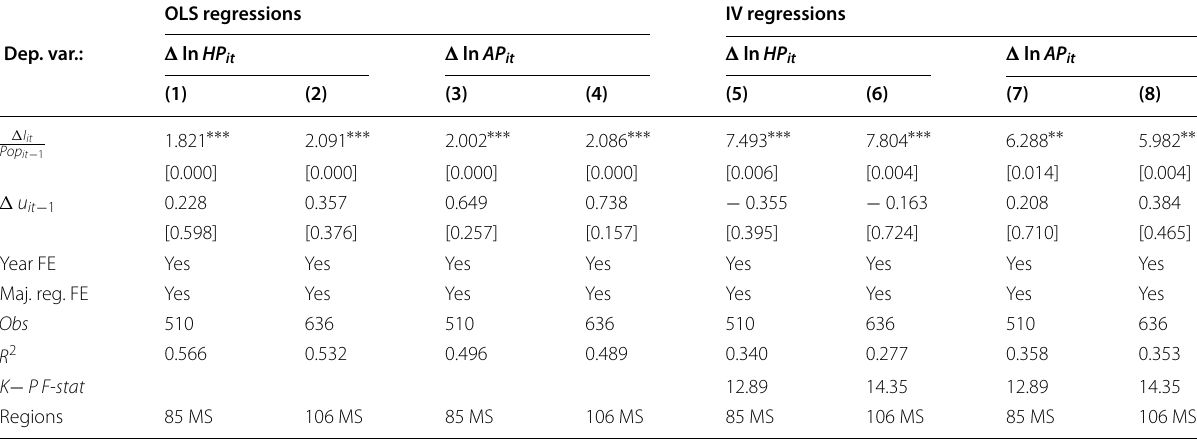
Table 11 Housing prices and immigration—MS-regions from 2001–2006: OLS and IV regressions. Source: Own calculations based on data from Wüest Partner and Federal Statistical